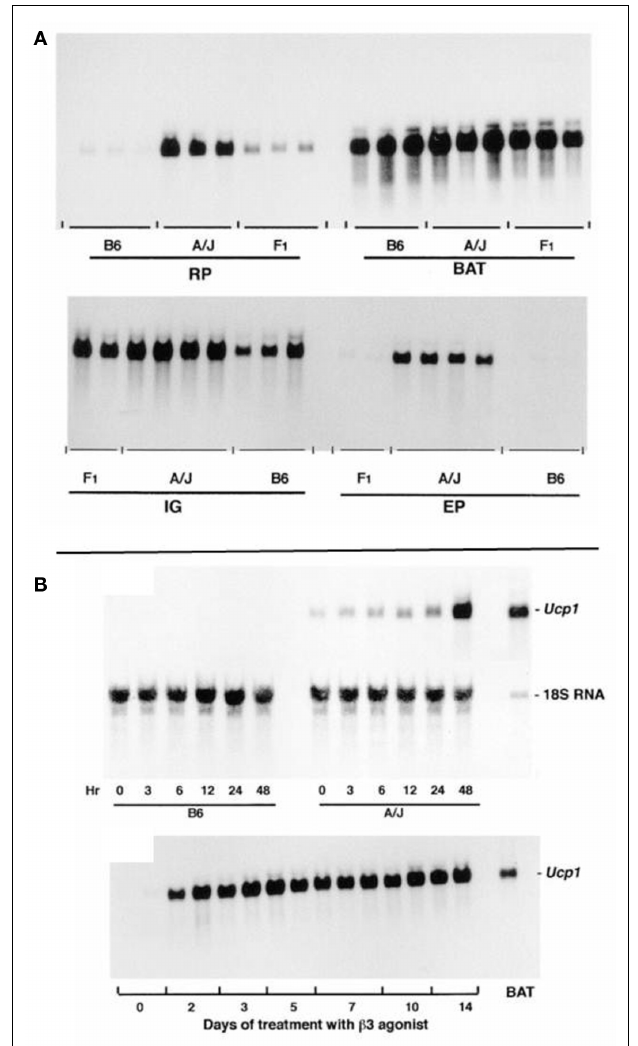
FIGURE 1 | (A) The levels of Ucp 1 mRNA in the retroperitoneal fat ( RP ), interscapular brown fat ( BAT ), inguinal fat ( IG ), and epididymal fat ( EP ) in total RNA isolated from A/J, B6, and (B6 × A/J) F1 mice are shown. Mice were treated with the β 3-adrenergic agonist CL 316,243 for 7days before isolation of RNA, at a time when induction of Ucp 1 mRNA had reached a plateau.Ten microgram of RNA from BAT was analyzed and 15 μ g from the other fat depots. (B) Northern blot analysis of total RNA. (Upper panel)The induction of Ucp 1 mRNA in the retroperitoneal fat pad of B6 and A/J mice when placed in the cold at 5˚C as indicated between 0 and 48h.Total RNA was isolated from tissues pooled from three mice. Fifteen microgram of RNA was analyzed. (Lower panel)The induction of Ucp 1 mRNA in the retroperitoneal fat pad after injection of the β 3-adrenergic agonist, CL 316,243, once a day in the late afternoon at a dose of 1mg/kg body wt. RNA (15 μ g) from two mice was analyzed individually. A standard of 2.7 μ g of interscapular brown fat RNA was included on the